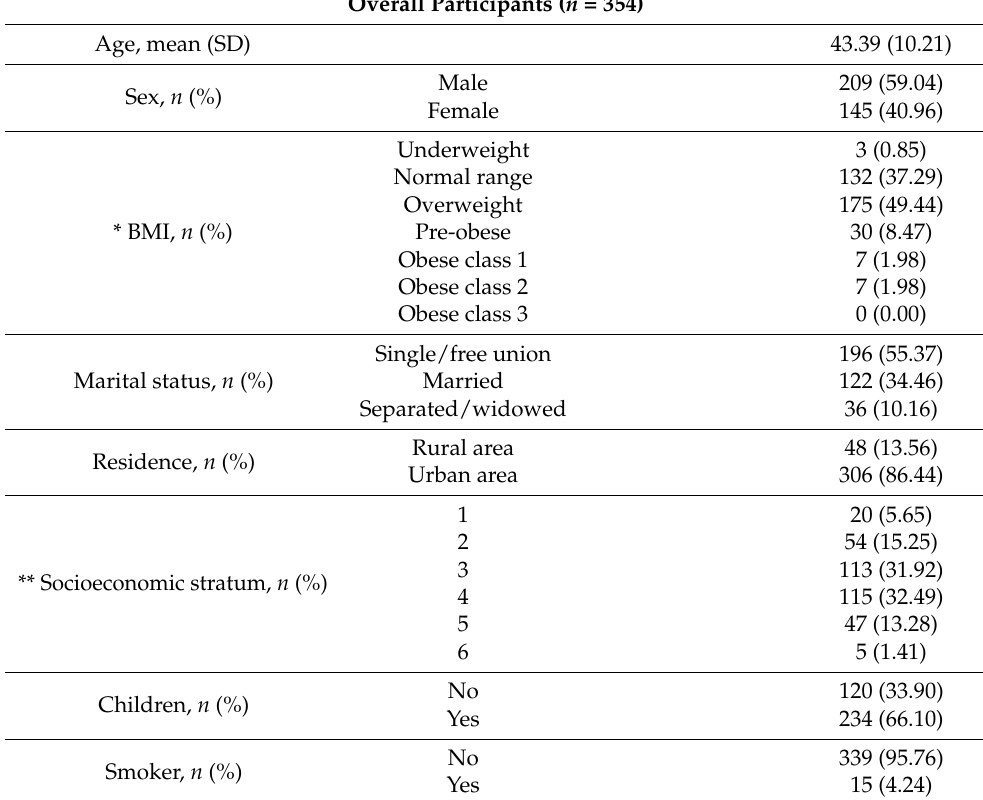
Table 1. Descriptive data of the participants ( n = 354).